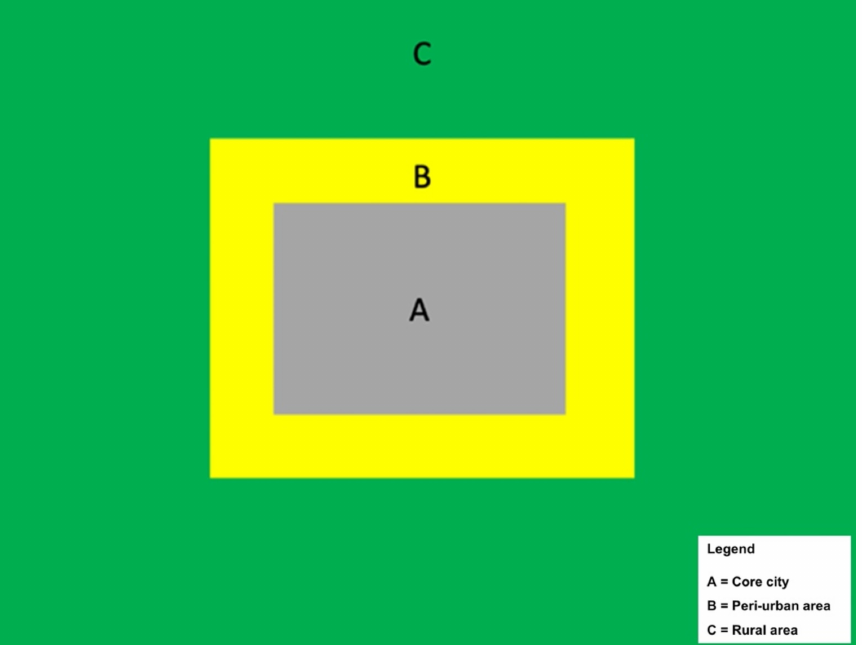
Figure 1. A schematic view of the urban multifunctional landscape where A indicates the core city, B represents the peri-urban area, and C is the rural